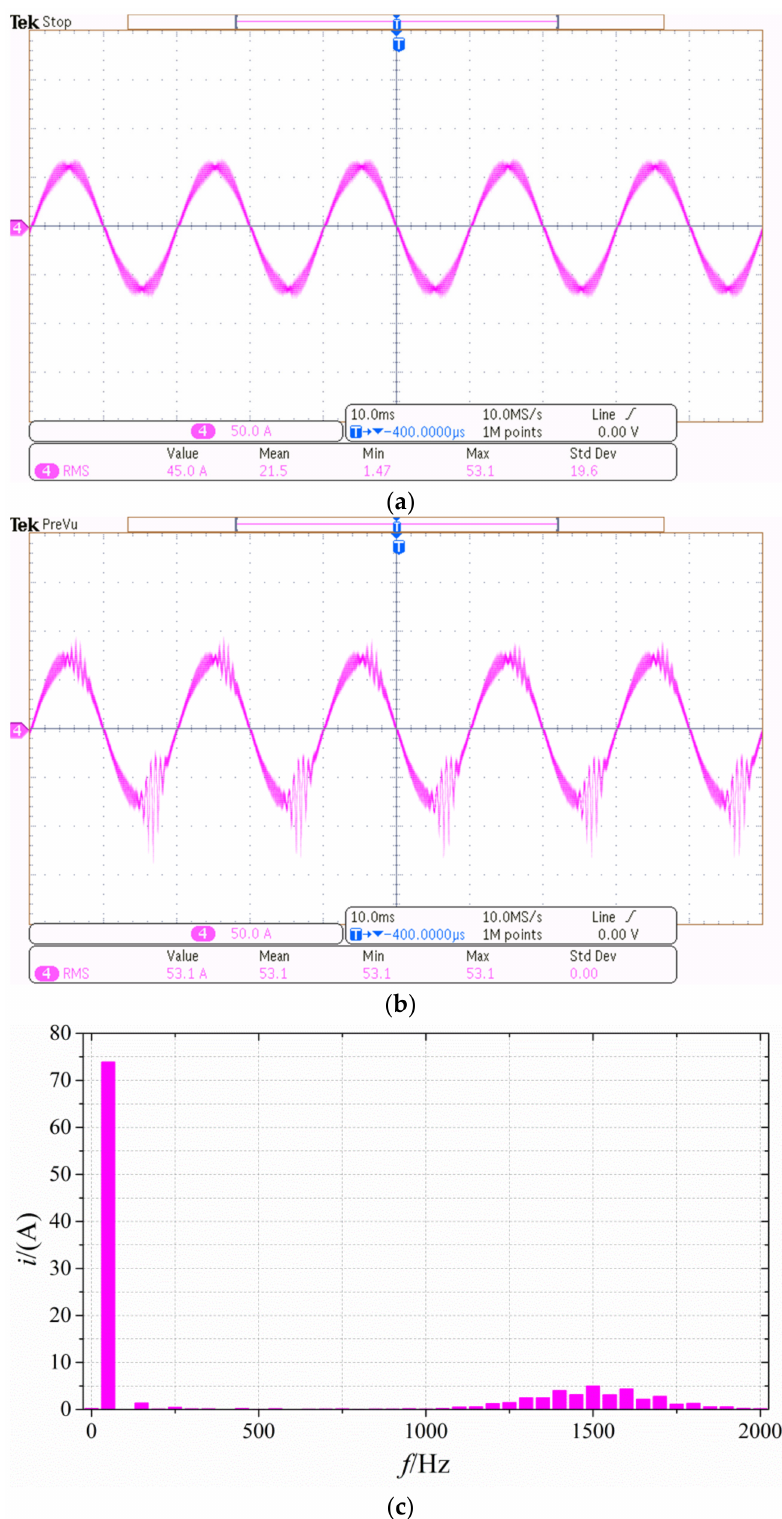
Figure 10. Experimental results with different magnitudes of output current reference before the loop gain compensation unit is introduced: ( a ) magnitude of output current reference is 60 A; ( b ) magnitude of output current reference is 70 A; ( c ) spectra of the output current when its reference magnitude is 70